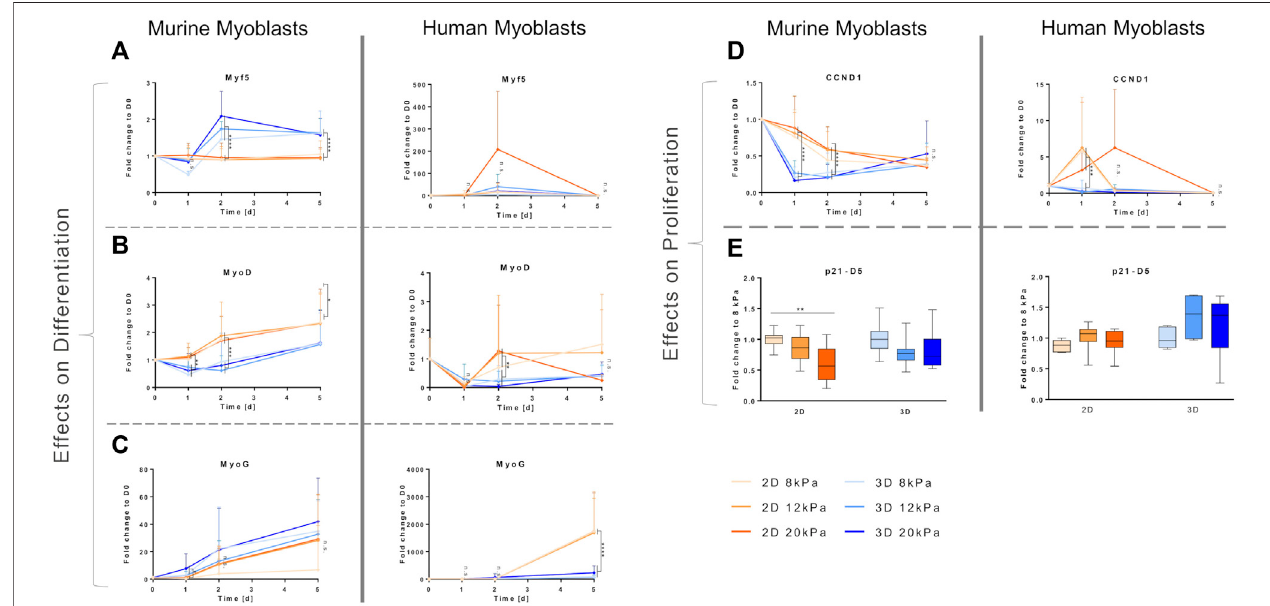
FIGURE 5 | Culture on more rigid substrates interferes with myotube maturation. Murine and human myoblasts were differentiated on fi brin-coated cell culture plates(2D; (A – C) orembeddedin fi brinhydrogels(3D; (D) withdifferentstiffness(apparenttensilemodulusof8,12and20 kPa)for5 days. (A) Representativeimagesof immuno fl uorescence(IF) stainings forMHC(green)withnucleistainedwithDAPI(blue).Scalebars represent 500 µm. (B) Myotubefusion indexofIFstainings (MHCand DAPI); analyzed as the ratio of fused nuclei to total nuclei per visual fi eld ( N = 4, n ≥ 10 for murine myoblasts, N = 3, n ≥ 9 for human myoblasts with four regions of interest,atleast400nucleipersampleand4000nucleiperexperimentalgroupanalyzed.Dataisshownasboxandwhiskers(mintomax);one-wayANOVAwithTukey ’ s multiple comparison test was performed comparing all rigidities with each other with no signi fi cant differences found. (C) Myotube alignment score of IF stainings (MHC and DAPI); analyzed as the deviation of single myotubes from the main axis of orientation, represented as a histogram of the percentage of myotubes deviating in the respectiveintervalof10 ° angles.( N =4, n ≥ 10formurinemyoblasts, N =3, n ≥ 9forhumanmyoblastswithatleast180myotubesperexperimentalgroupanalyzed.Data is shown as mean + SD; one-way ANOVA with Tukey ’ s multiple comparison test was performed comparing all rigidities of each deviation interval, * p < 0.05, ** p < 0.01. (D) Representative images of IF stainings for MHC (green) with nuclei stained with DAPI (blue) taken either at the edge or in the center of the hydrogels. White arrows indicate myocytes. Scale bars represent 200 μ m; N = 2, n =